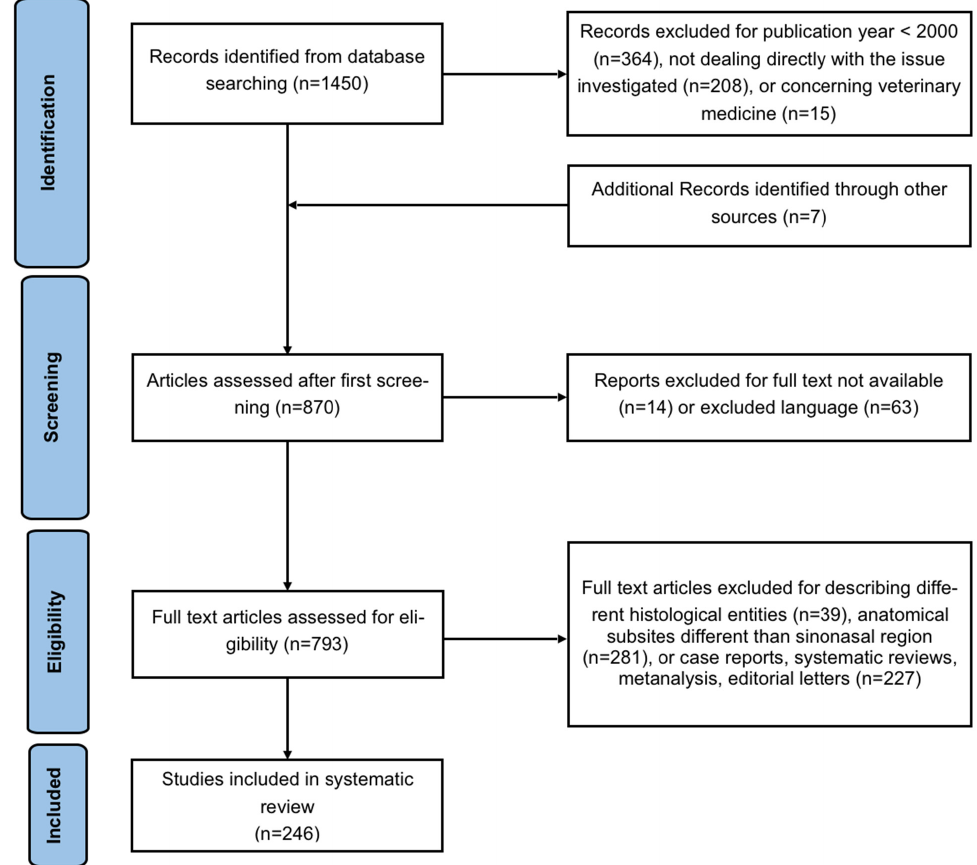
Figure 1. Flowchart of the article’s search and selection procedure according to the PRISMA criteria. Ciclin-dependent kinase (CDK) complexes, which promote transition between dif- ferent phases of the cell cycle, and CDK inhibitors (CDKI) have also been found to be deregulated in IP with malignant transformation potential and in